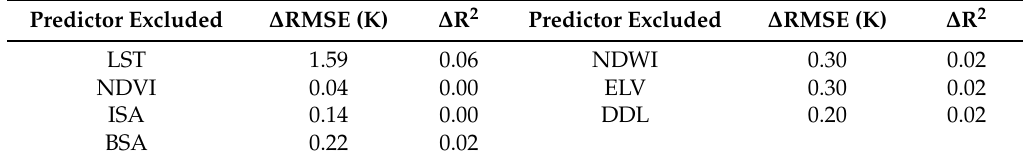
Table 4. Averaged error increase by excluding each one of the seven predictors from the regression. Predictor Excluded ∆ RMSE (K) ∆ R 2 Predictor Excluded ∆ RMSE (K) ∆ R 2 LST 1.59 0.06 NDWI 0.30 0.02 NDVI 0.04 0.00 ELV 0.30 0.02 ISA 0.14 0.00 DDL 0.20 0.02 BSA 0.22